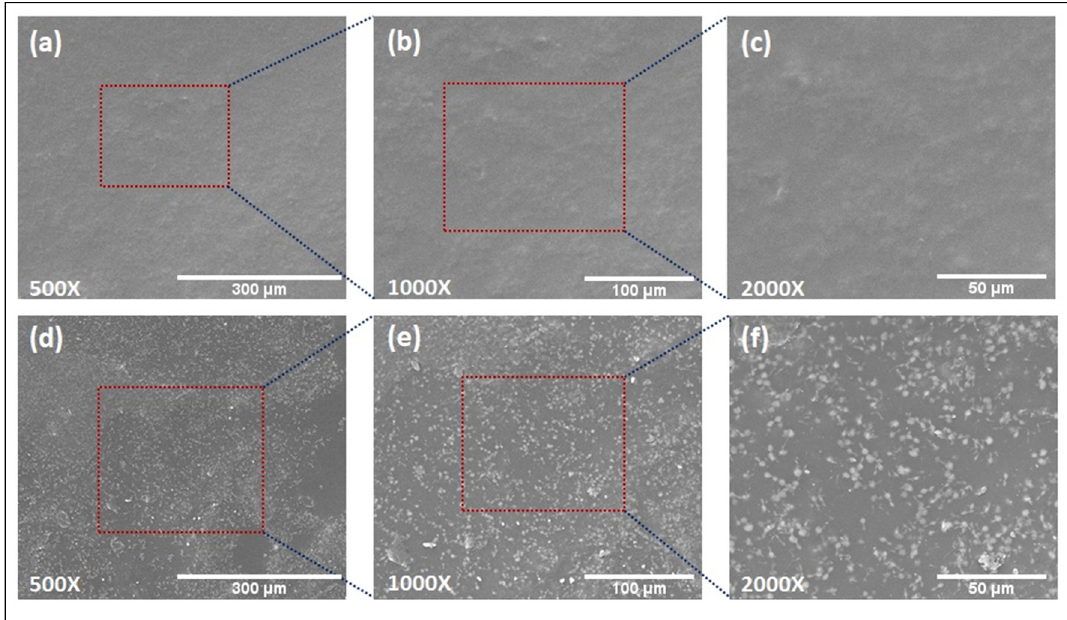
Figure 1. Scanning electron microscope (SEM) images of AXGL5 (blank) film ( a – c ) and AXGL5D (gentamicin (GM)-loaded) film ( d – f ) captured at 500×, 1000×, and 2000× magnifications.